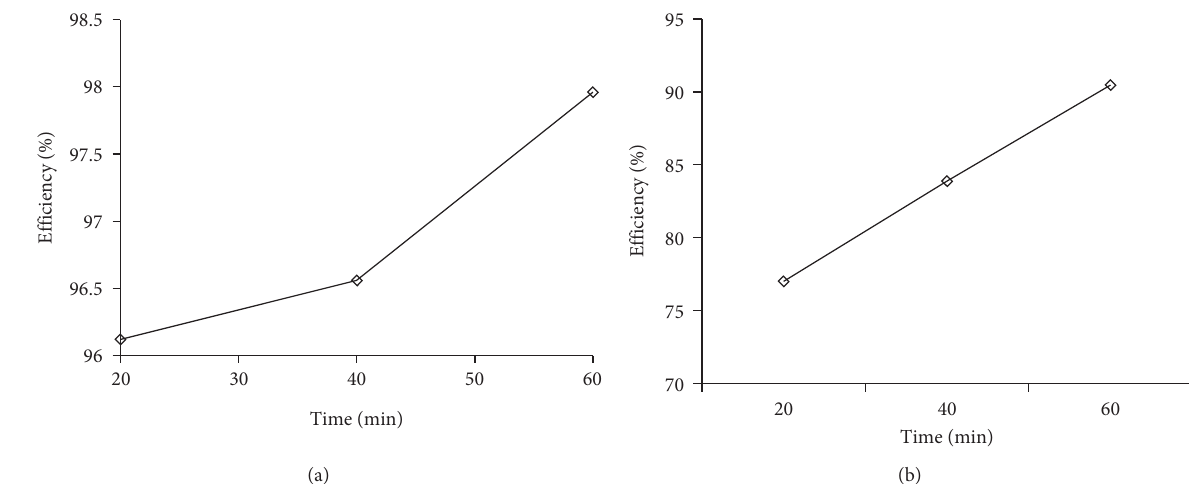
Figure 5: Trifloralin removal efficiency: (a) for 40 µ M concentration of persulfate (initial trifluralin concentration: 1.2mg/L, PH � 9, UV � 6 W) and (b) for 100mg/L concentration of ZnO (initial trifluralin concentration: 0.6mg/L, pH � 9, UV � 6 W).